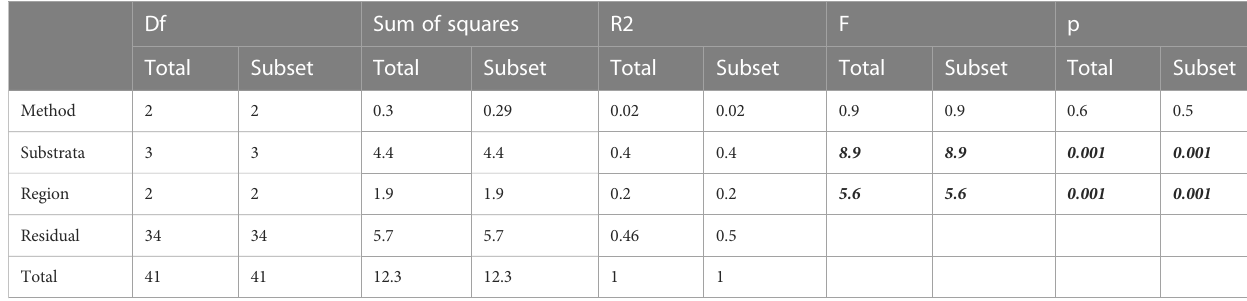
TABLE 3 PERMANOVA analysis of the in fl uence of method (diver or ROV), survey substrata and region on the invasive species pro fi les for the entire suite of NIS detected (Total) and for the target subset (Subset). Df Sum of squares R2 F Subset